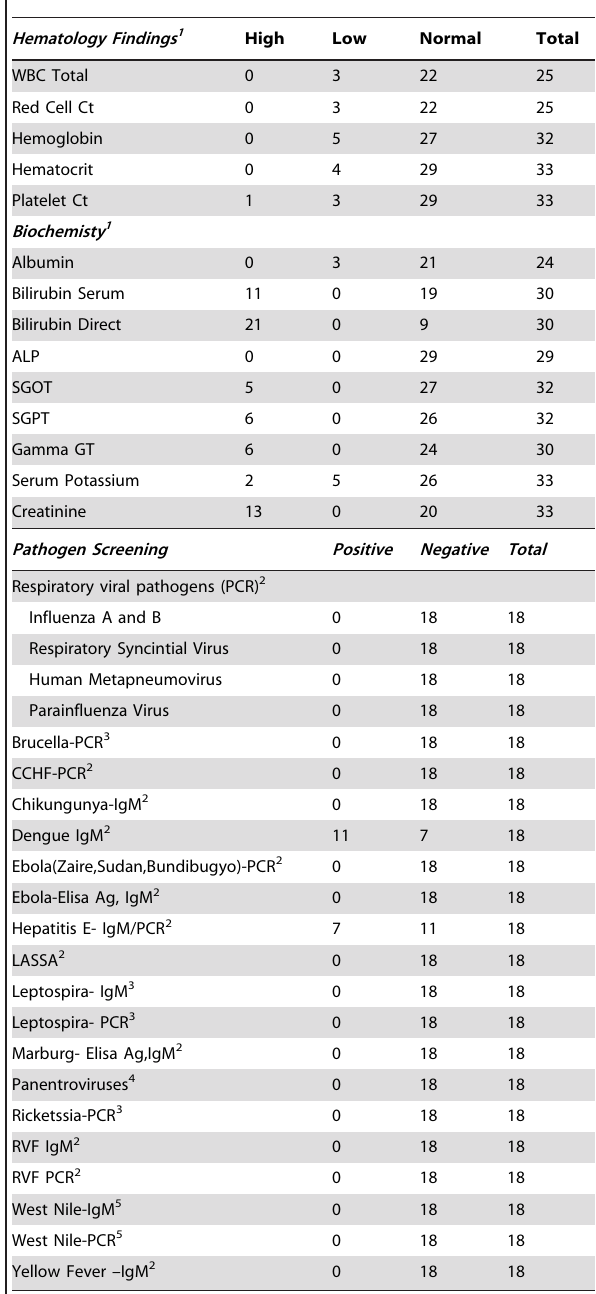
Table 1. Available laboratory results for cases referred for admission to AKUH-N